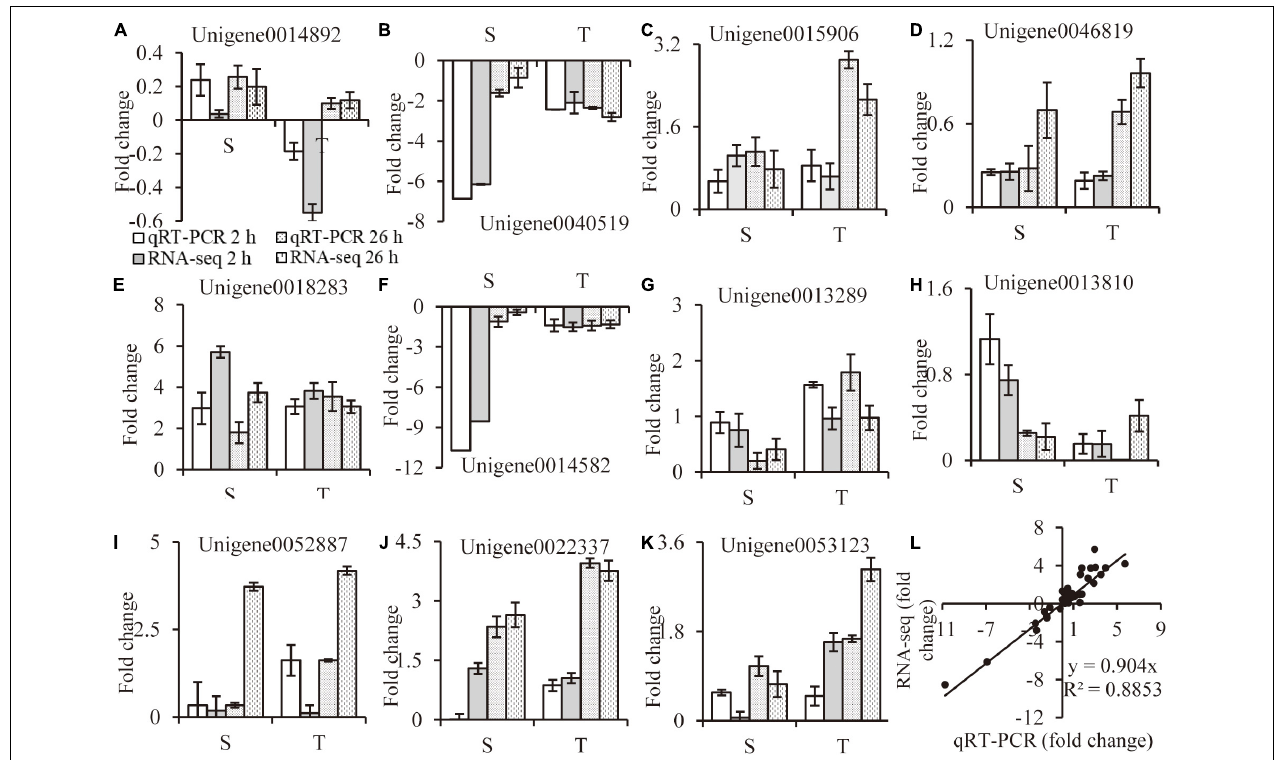
FIGURE 9 | RNA-seq data validation. Random selected genes with different expression patterns were analyzed by qRT-PCR (A–K) , correlation between qRT-PCR and RNA-seq data are calculated (L) . Values are mean ± SE ( n = 3